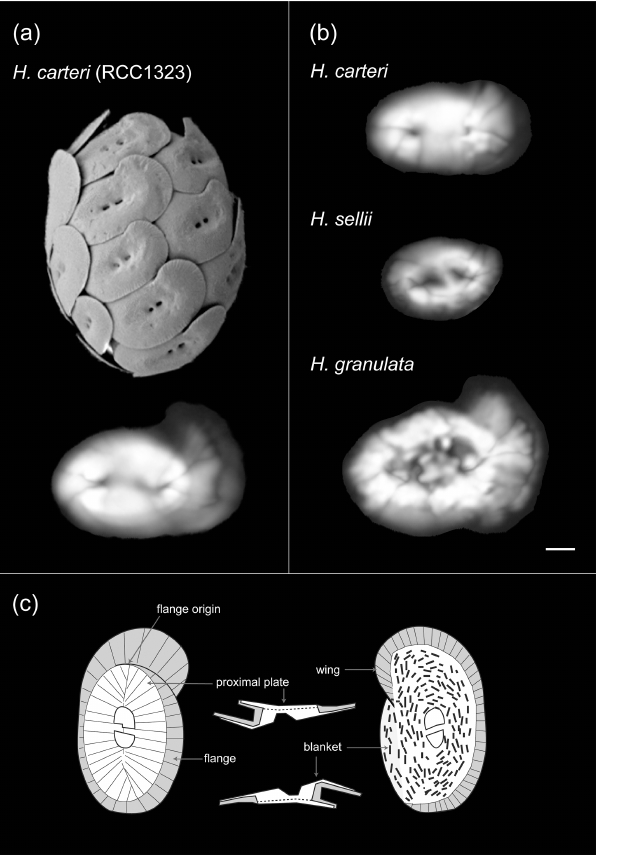
Figure 1. Helicosphaera coccosphere and coccolith morphology. (a) Scanning electron micrograph of a Helicosphaera carteri cocco- sphere and a polarized light microscope image of an individual coc- colith obtained from culture (Atlantic strain RCC 1323). (b) Light microscope images of coccoliths belonging to fossil Helicosphaera species analyzed in this study: H. carteri , H. granulata and H. sellii . Scale bar = 2µm. (c) Schematic illustration of Helicosphaera coc- colith morphology and calcite birefringence under cross-polarized light (after Young et al., 2004). Note the distinction between the birefringent blanket area (white) and the partially birefringent area of the coccolith wing or flange